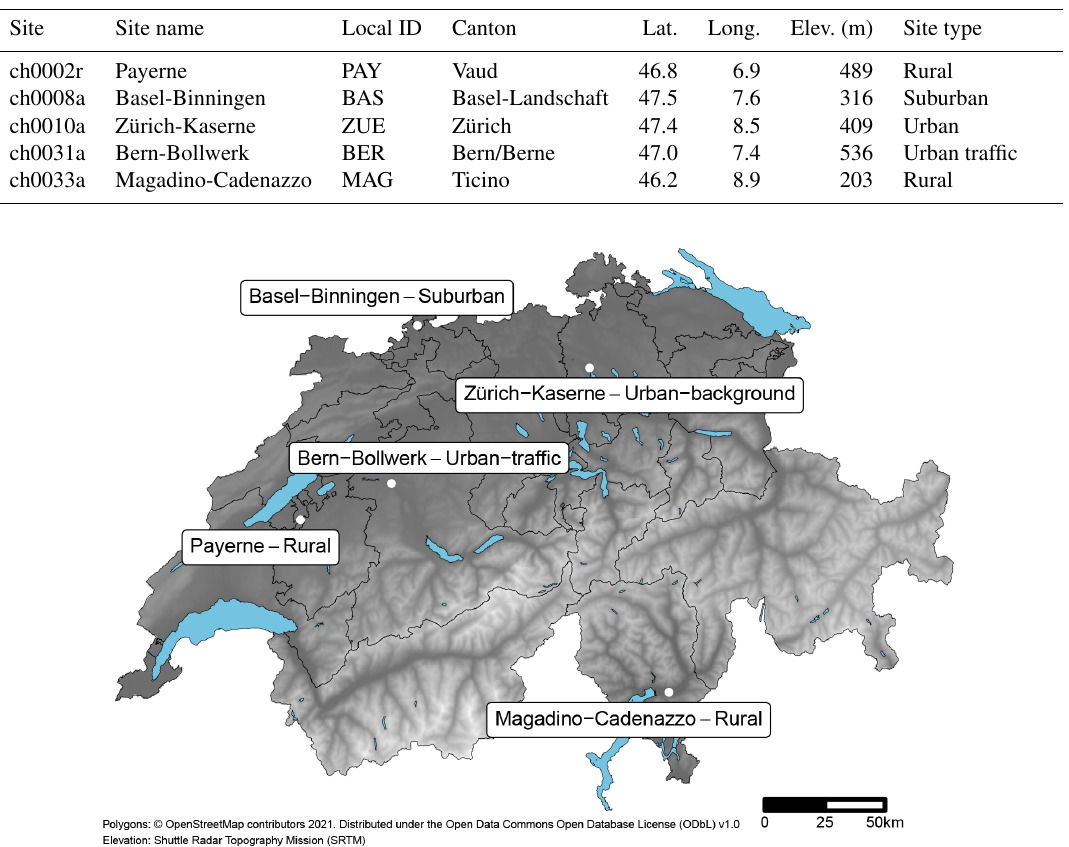
Figure 1. The five sampling sites in Switzerland that were used for PM oxidative potential measurements. The shading indicates the elevation of the terrain and the blue areas show larger lakes and reservoirs. The cantonal boundaries are displayed as